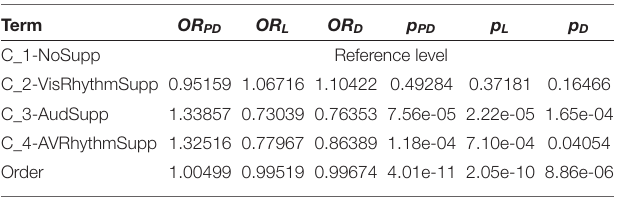
TABLE 4 | Odds ratios (OR) of the terms Condition and Order in the X1 models for all three outcome scores. Term OR PD OR L OR D p